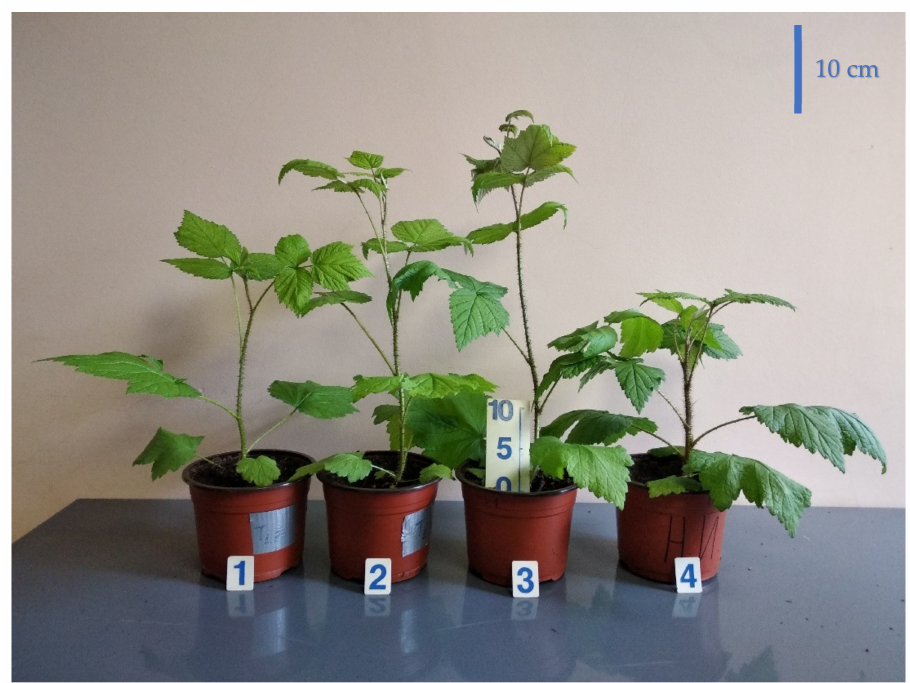
Figure 2. Raspberry plant growth responses to different red (R 660 )–far-red (FR) ratio in the light spec- trum. Photo of representative plants, 45 days after transplanting. Treatment 1—0% R 660 + 100% FR; Treatment 2—30% R 660 + 70% FR; Treatment 3—70% R 660 + 30% FR; Treatment 4—100% R 660 + 0%